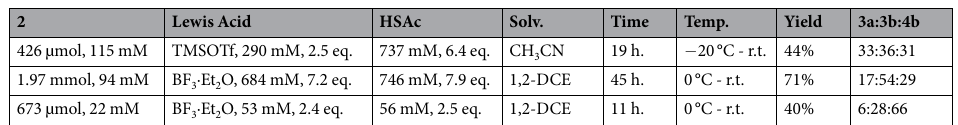
Table 1. Reaction conditions and yields for synthesis of acetylthio glycoside 3 and acetylthio pseudo-glycal 4b